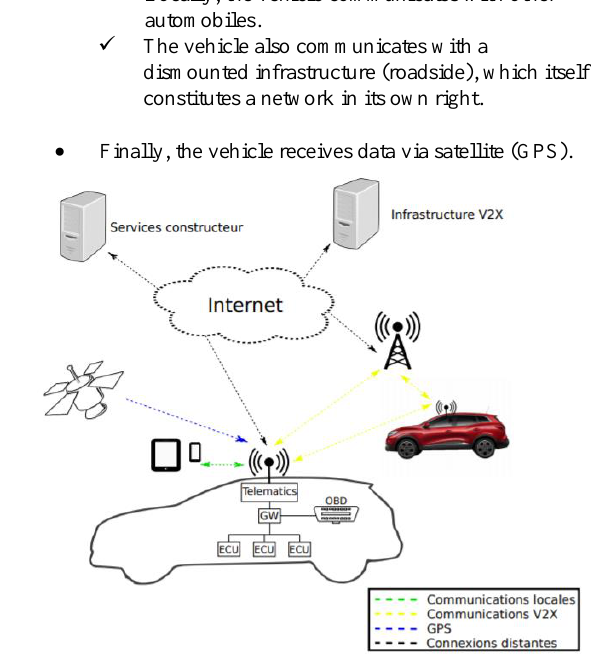
Figure 3. The different networks of an autonomous car.